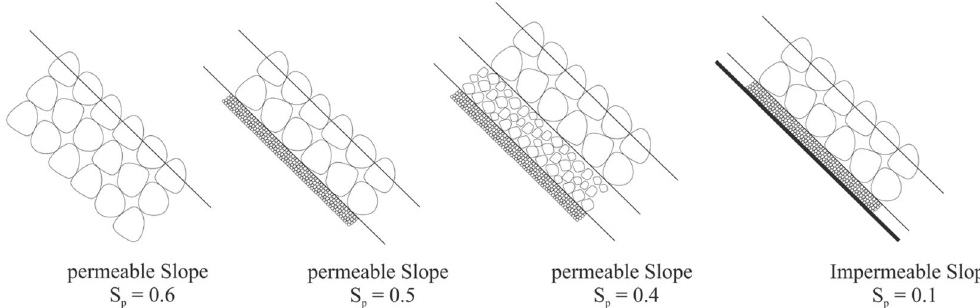
Figure 4. Bed permeability parameter for different types of bed materials.